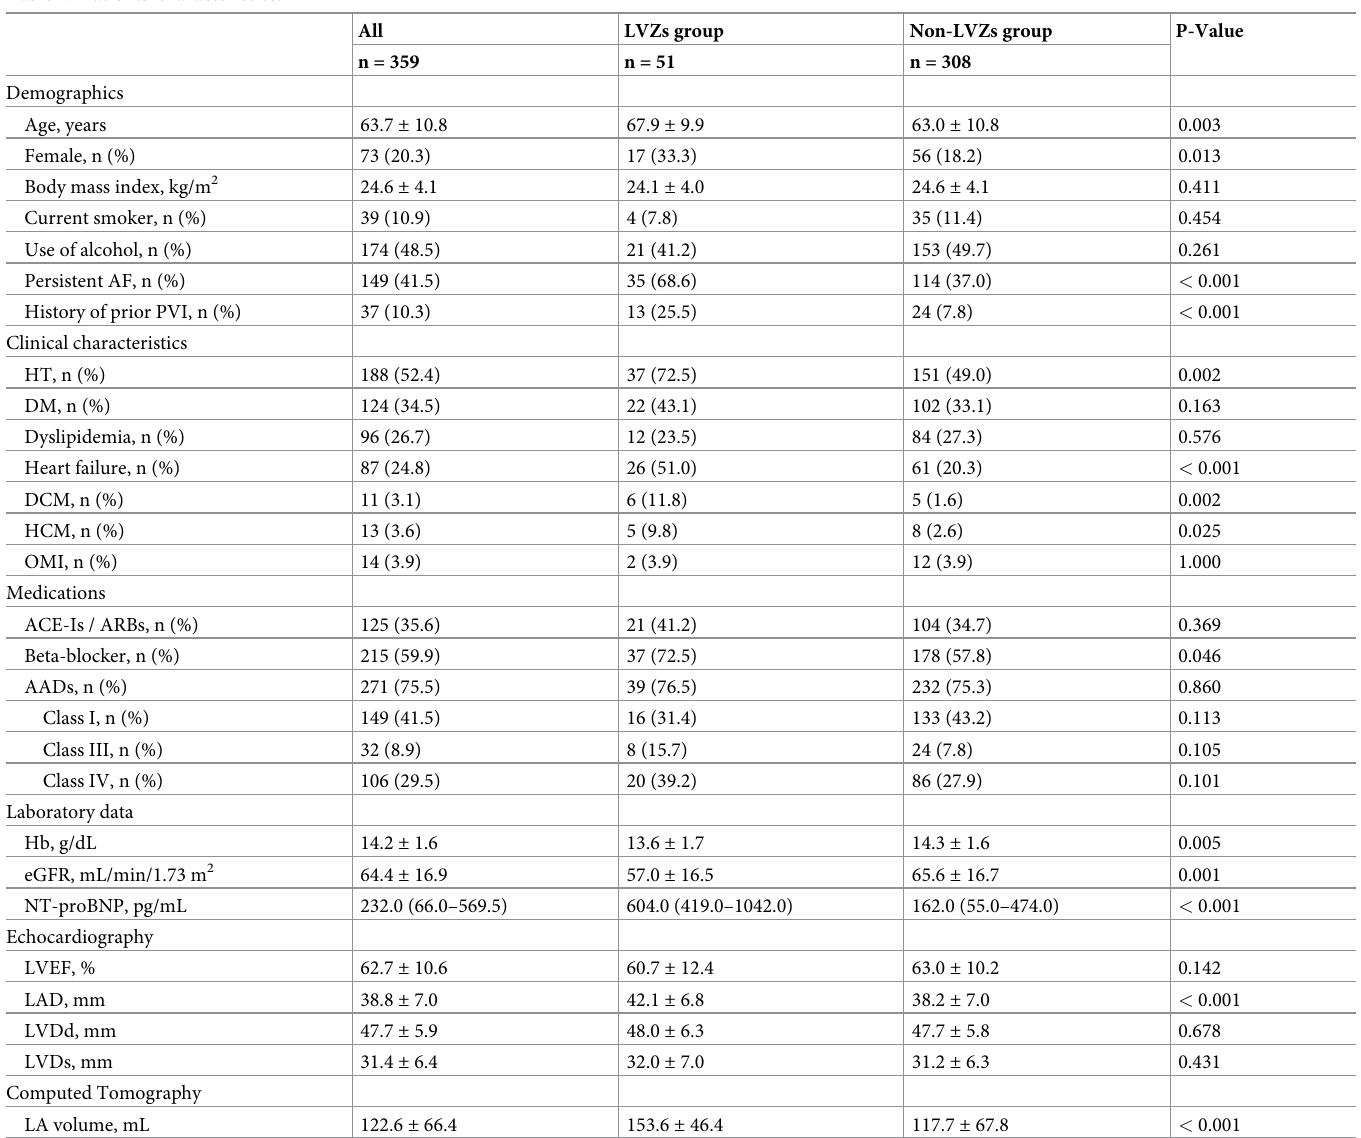
Table 1. Patients’